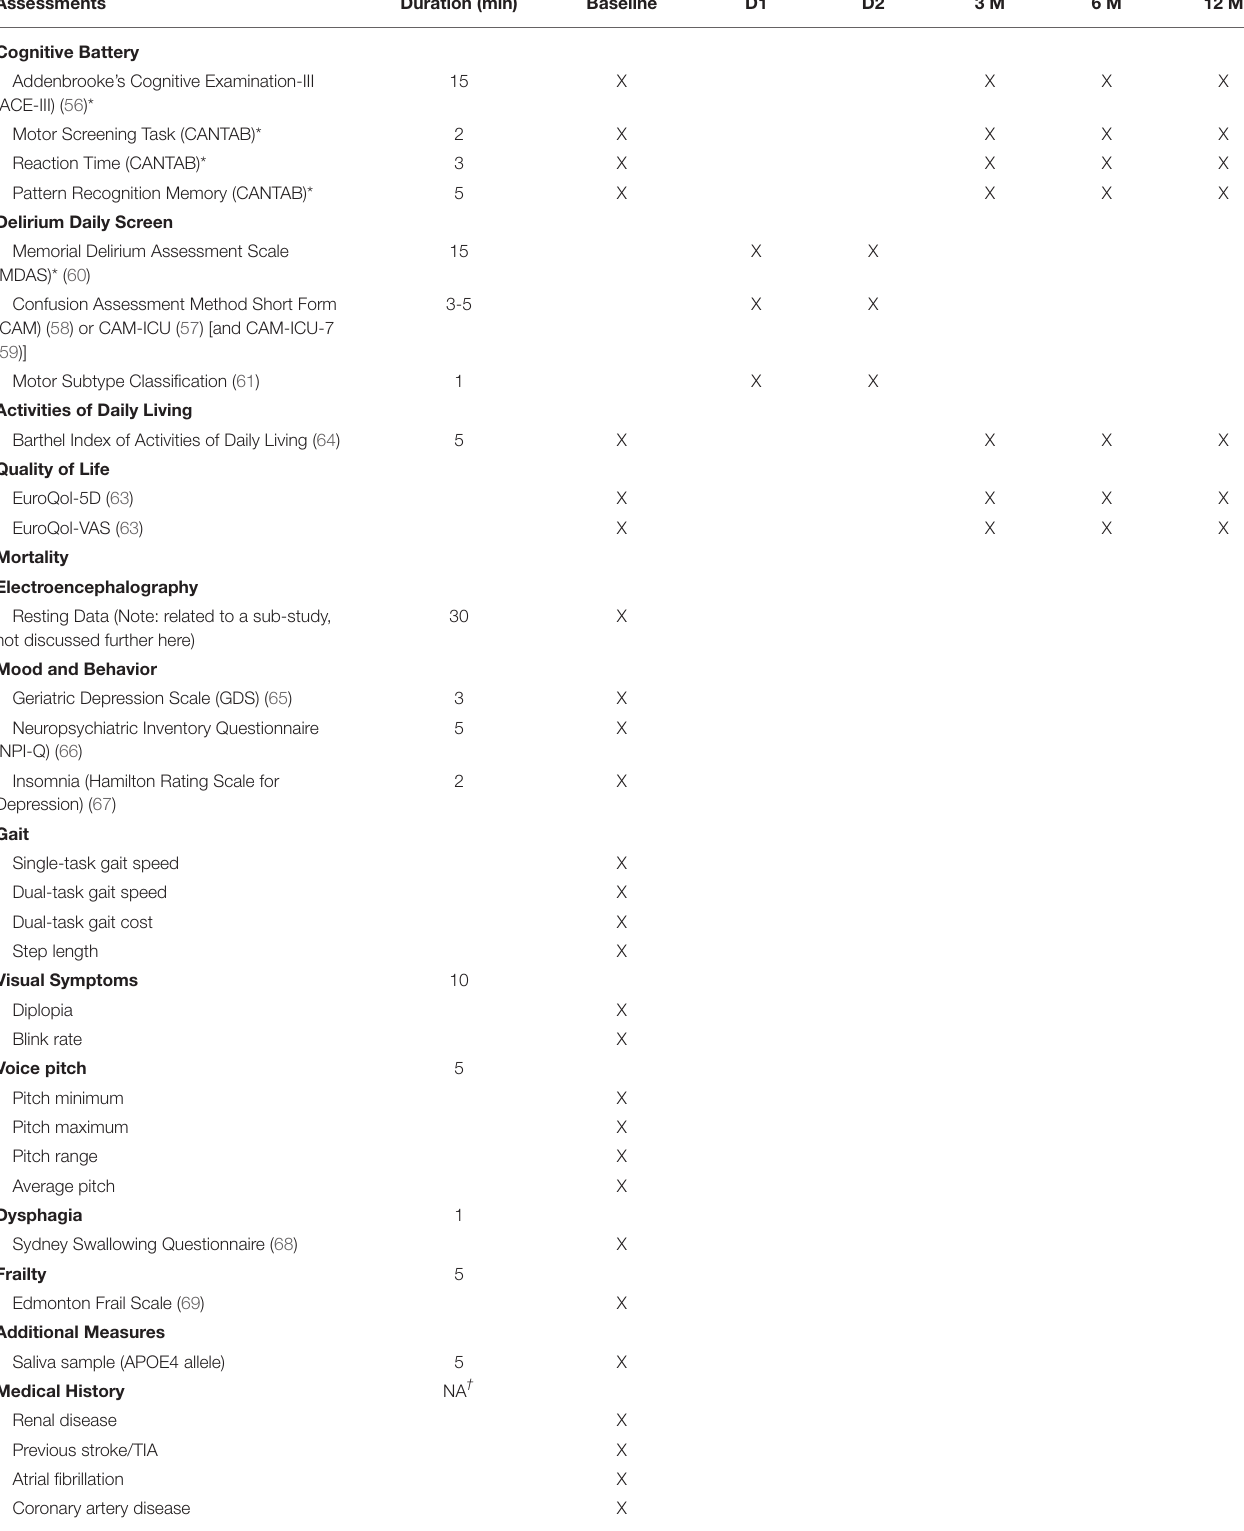
TABLE 2 | Measures and assessments utilized throughout study period, with approximate collection time. Assessments Cognitive